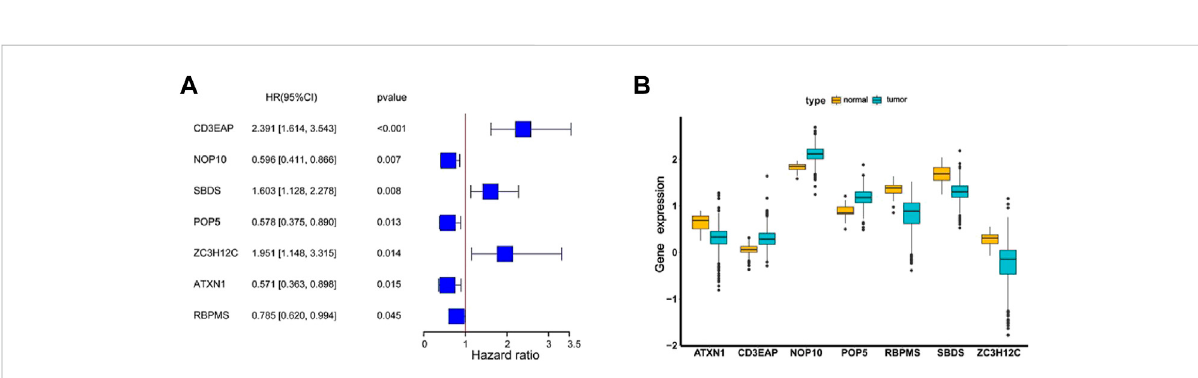
FIGURE 5 The coef fi cients and expression pro fi les of seven hub RBPs. (A) The coef fi cients of seven hub RBPs screened by univariate and multivariate Cox regression analysis. (B) The seven differently expressed genes were screened for expression in normal and cancer